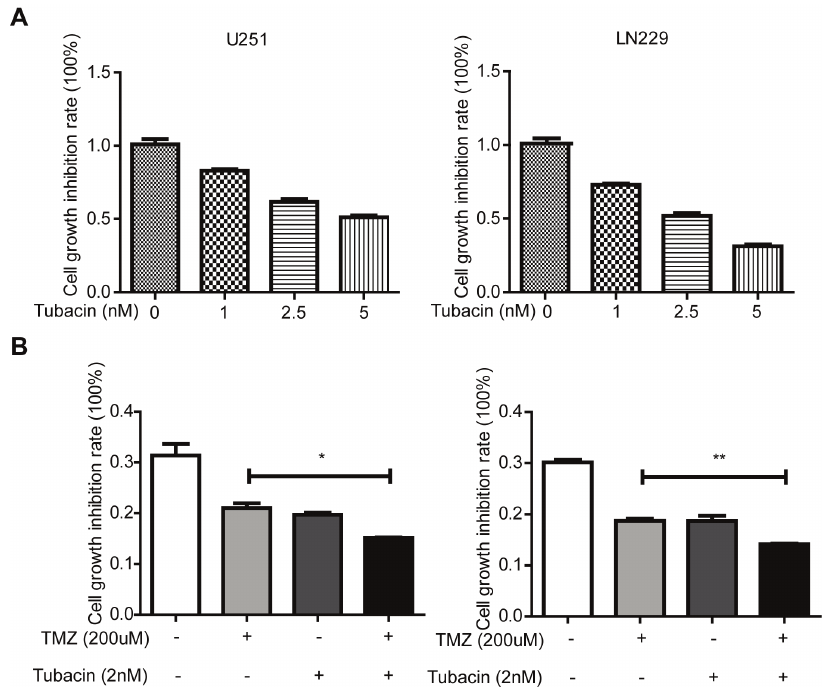
Figure 2: Tubacin inhibited the growth of glioma cells and enhanced the toxicity of temozolomide. (a) Human glioma cell lines LN229 and U251 were plated in 96-well plates (5×103/well) and cultured at 37°C for 24 hours. Then cells were treated with or without various concent- rations of tubacin for 8 hours. Cell growth was monitored by crystal violet staining. (b) LN229 and U251 cells were plated in 96-well plates. After 24 hours, cells were treated with or without TMZ (200μM) in the presence or absence of tubacin (2nM) at 37°C for 8 hours. Cell viability was measured by crystal violet staining.